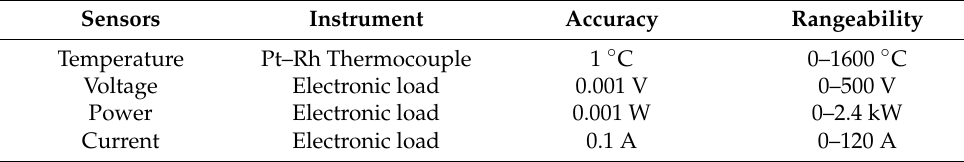
Table 3. Instruments used for model